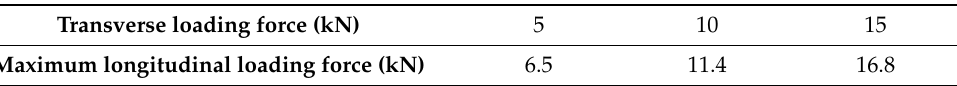
Figure 14. Vertical force. Table 2. Wedge tooth bearing test.